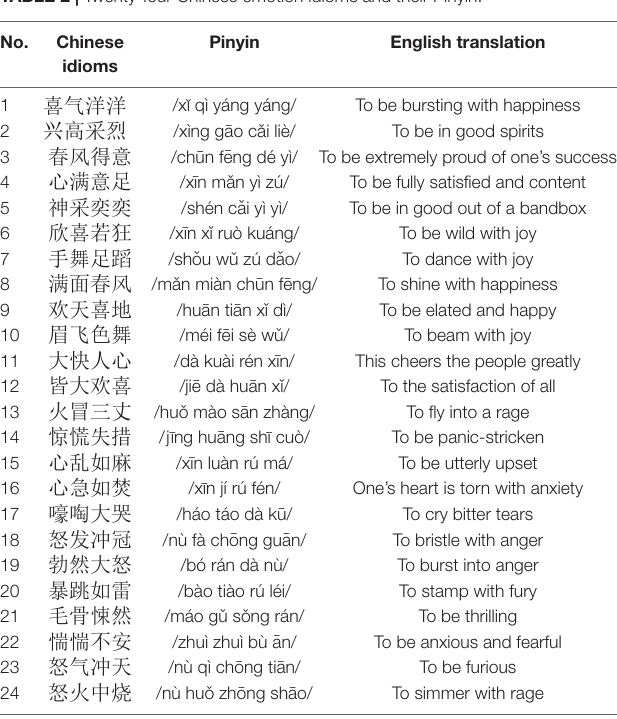
TABLE 2 | Twenty-four Chinese emotion idioms and their